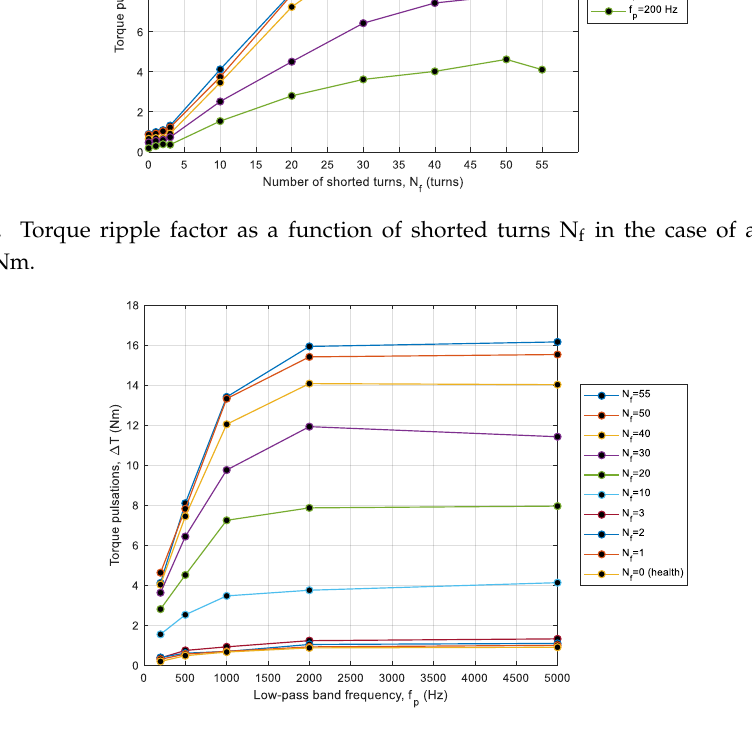
Figure 16. Torque ripple factor as a function of low-pass filter frequency fp in the case of a faulty motor, at T L = 0 Nm. at T L = 0